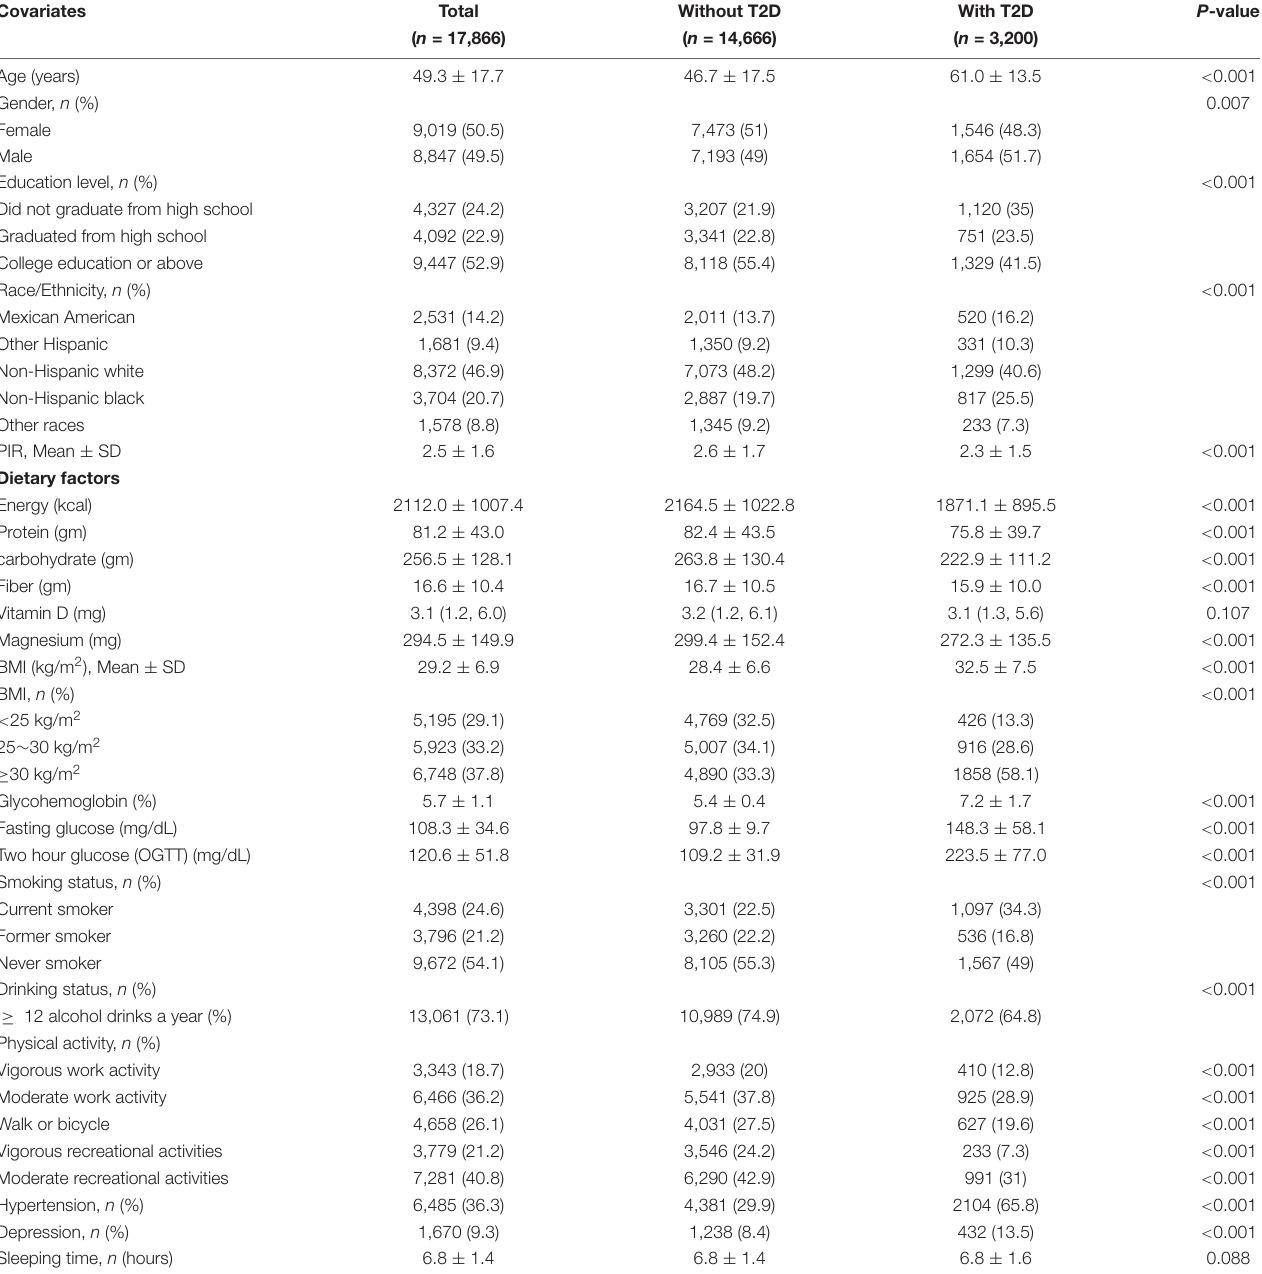
TABLE 1 | Baseline characteristics of